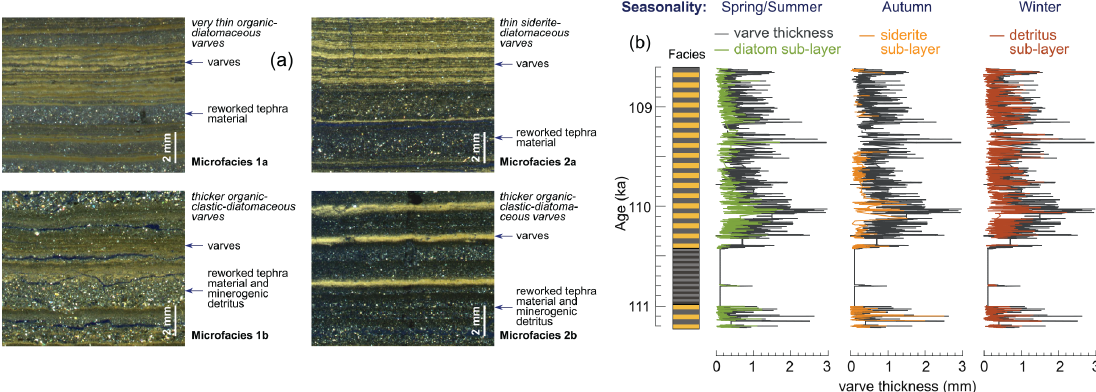
Figure 3. Sedimentological and elemental composition of the varved sediments of Lago Grande di Monticchio: (a) thin section images of the varved sediments of MON showing the different types of microfacies; (b) schematic lithological profile from 111 to 108ka (microfacies 1a and 2b); total varve thickness (grey) compared with thickness variability of the different